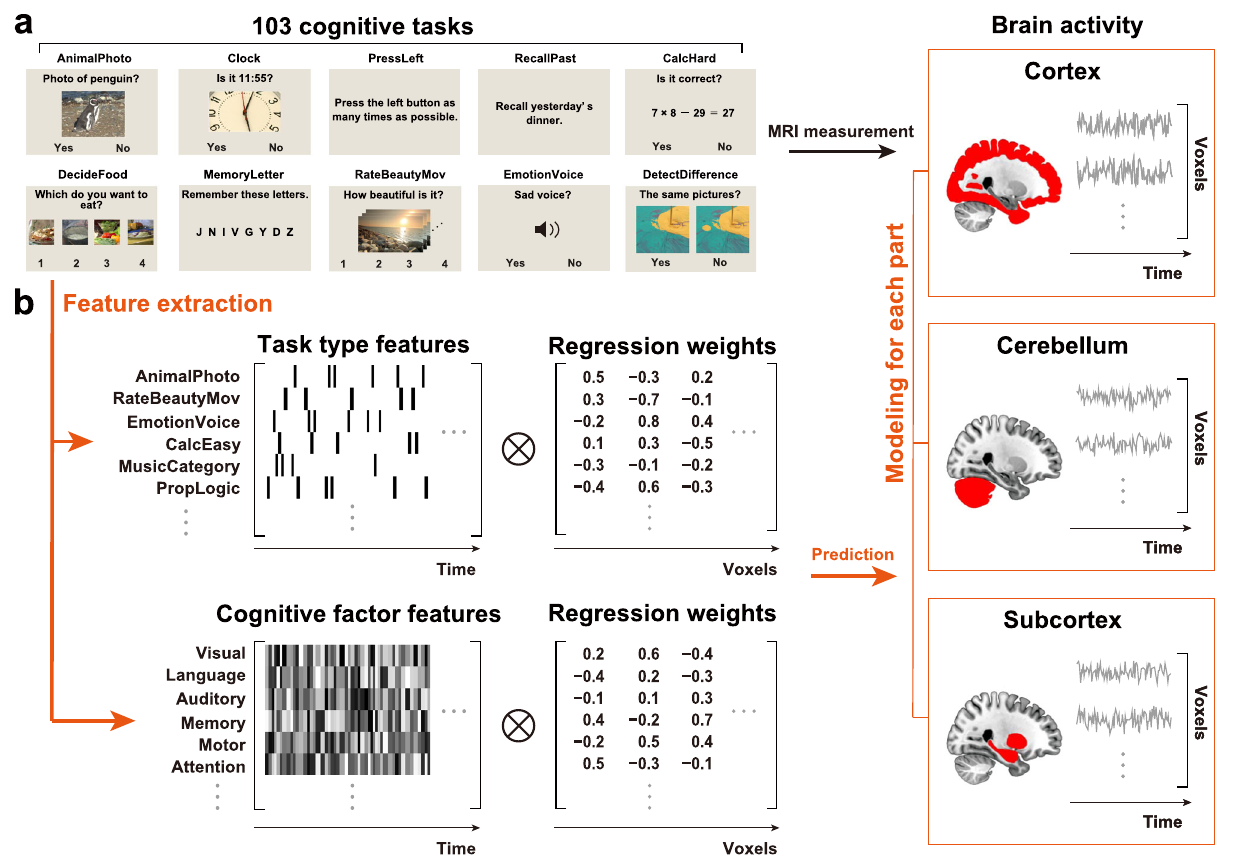
Fig. 1 Experimental design and analyses. Some fi gures were modi fi ed from one of our previous studies 45 . a The subjects performed 103 naturalistic tasks while the brain activity was measured using functional magnetic resonance imaging. Ten example tasks were shown. b Schematic of the encoding model fi tting using the sparse task-type and continuous cognitive factor features. Three different encoding models were constructed using ridge regression, with cortical, cerebellar, and subcortical